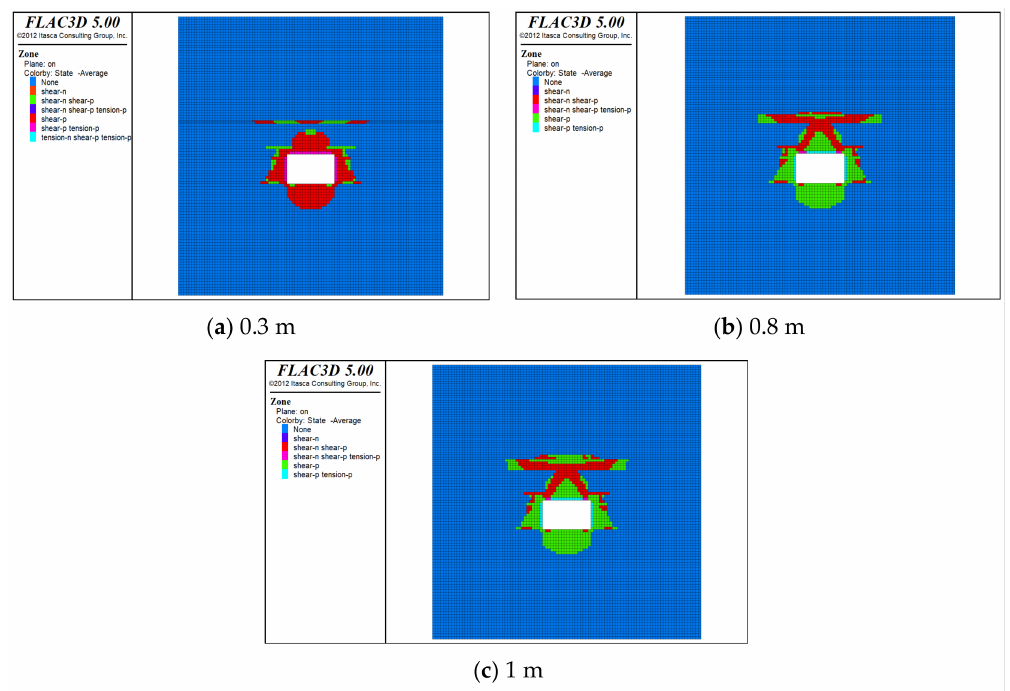
Figure 11. Distribution of plastic zones around rock in soft sandwich roadways of different